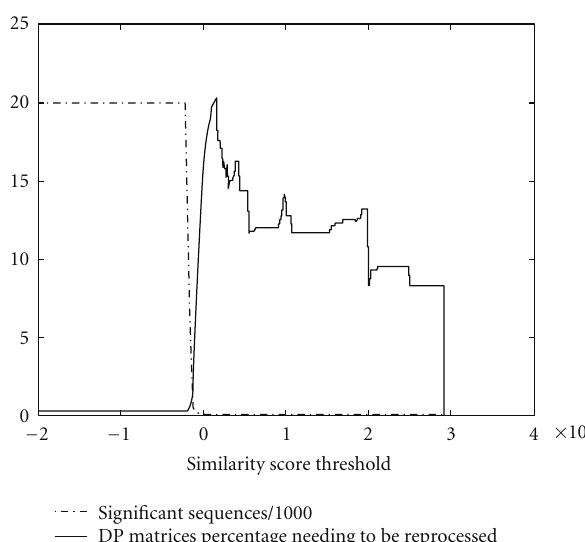
Figure 17: Number of significant sequences and DP percentage that is required to reprocess in software versus similarity score